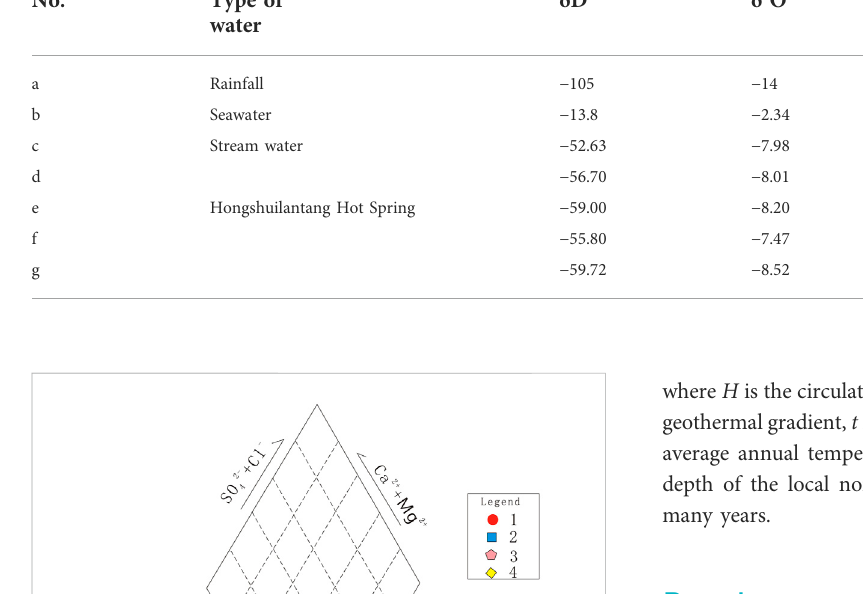
TABLE 2 δ D and δ 18 O stable isotope characteristics of different waters in Weihai city. No.